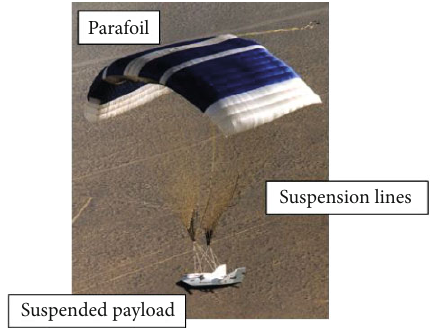
Figure 1: Typical parafoil at the X-38 mission [6].